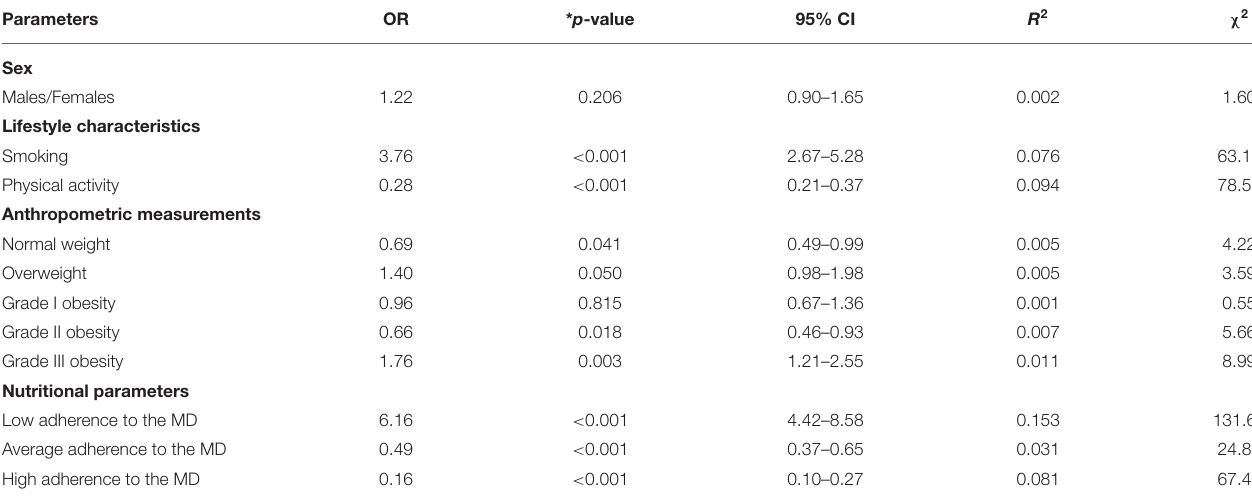
TABLE 6 | The results of a multinomial logistic regression to assess the association between the thyroid nodules presence/absence and categorical variables included in this study.